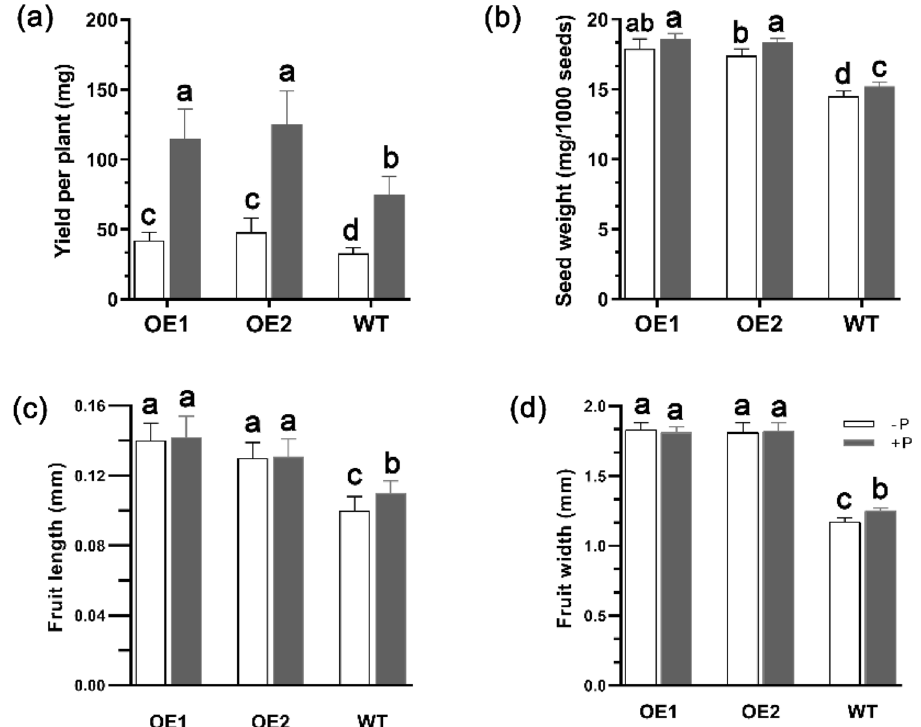
Figure 5. Yield traits in transgenic and wild-type Arabidopsis lines. ( a ) Seed yield of GmmiR156b overexpression (OE) and wild type (WT) plants under + P and − P conditions. ( b ) Seed weight of OE and WT plants under + P and − P conditions. ( c ) Fruit length of OE and WT plants under + P and − P conditions. ( d ) Fruit width of OE and WT plants under + P and − P conditions. Different letters above the bars indicate statistical significance ( P < 0.05).